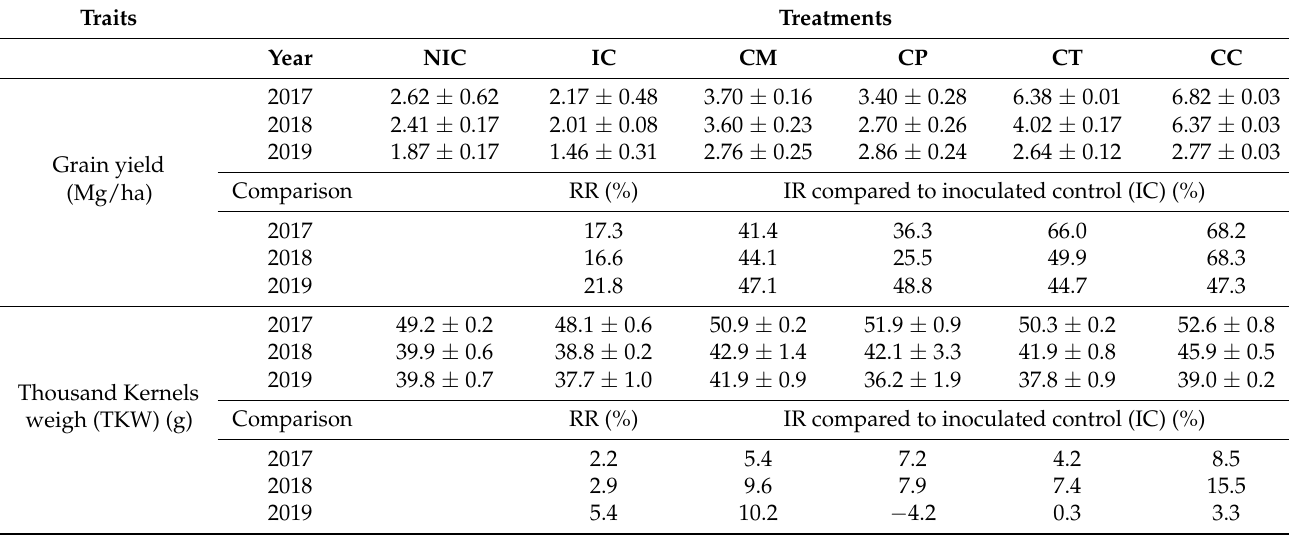
Table 4. Effect of treatments on yield components of durum wheat evaluated in a three-year study. Traits